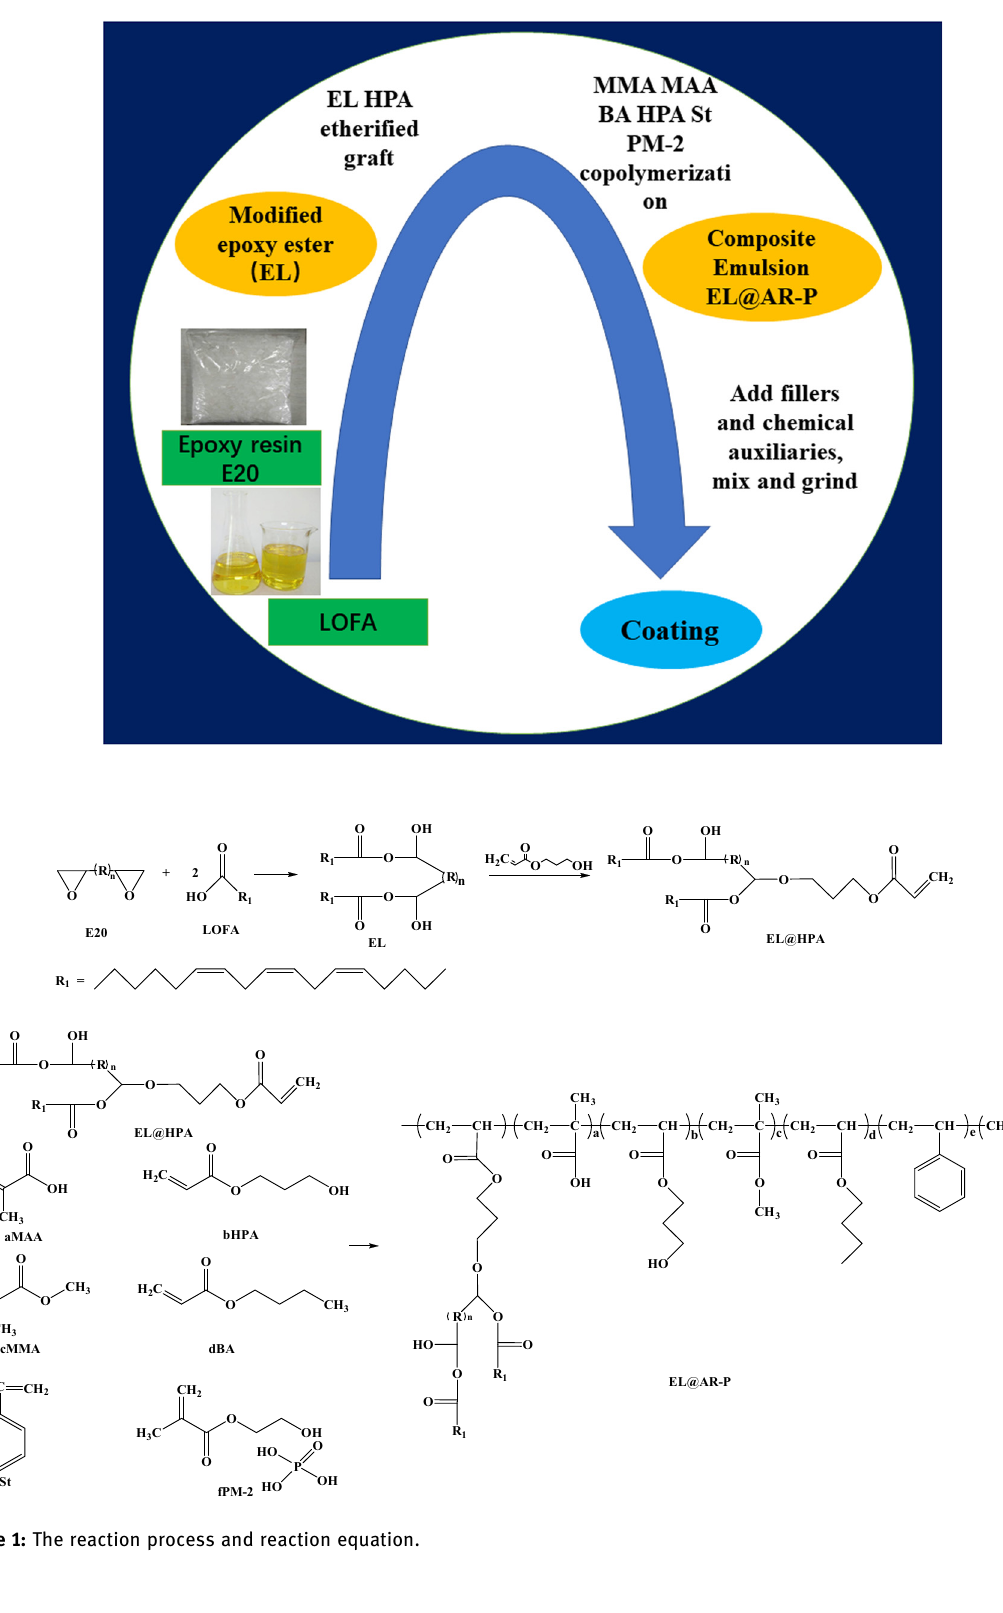
Figure 1: The reaction process and reaction